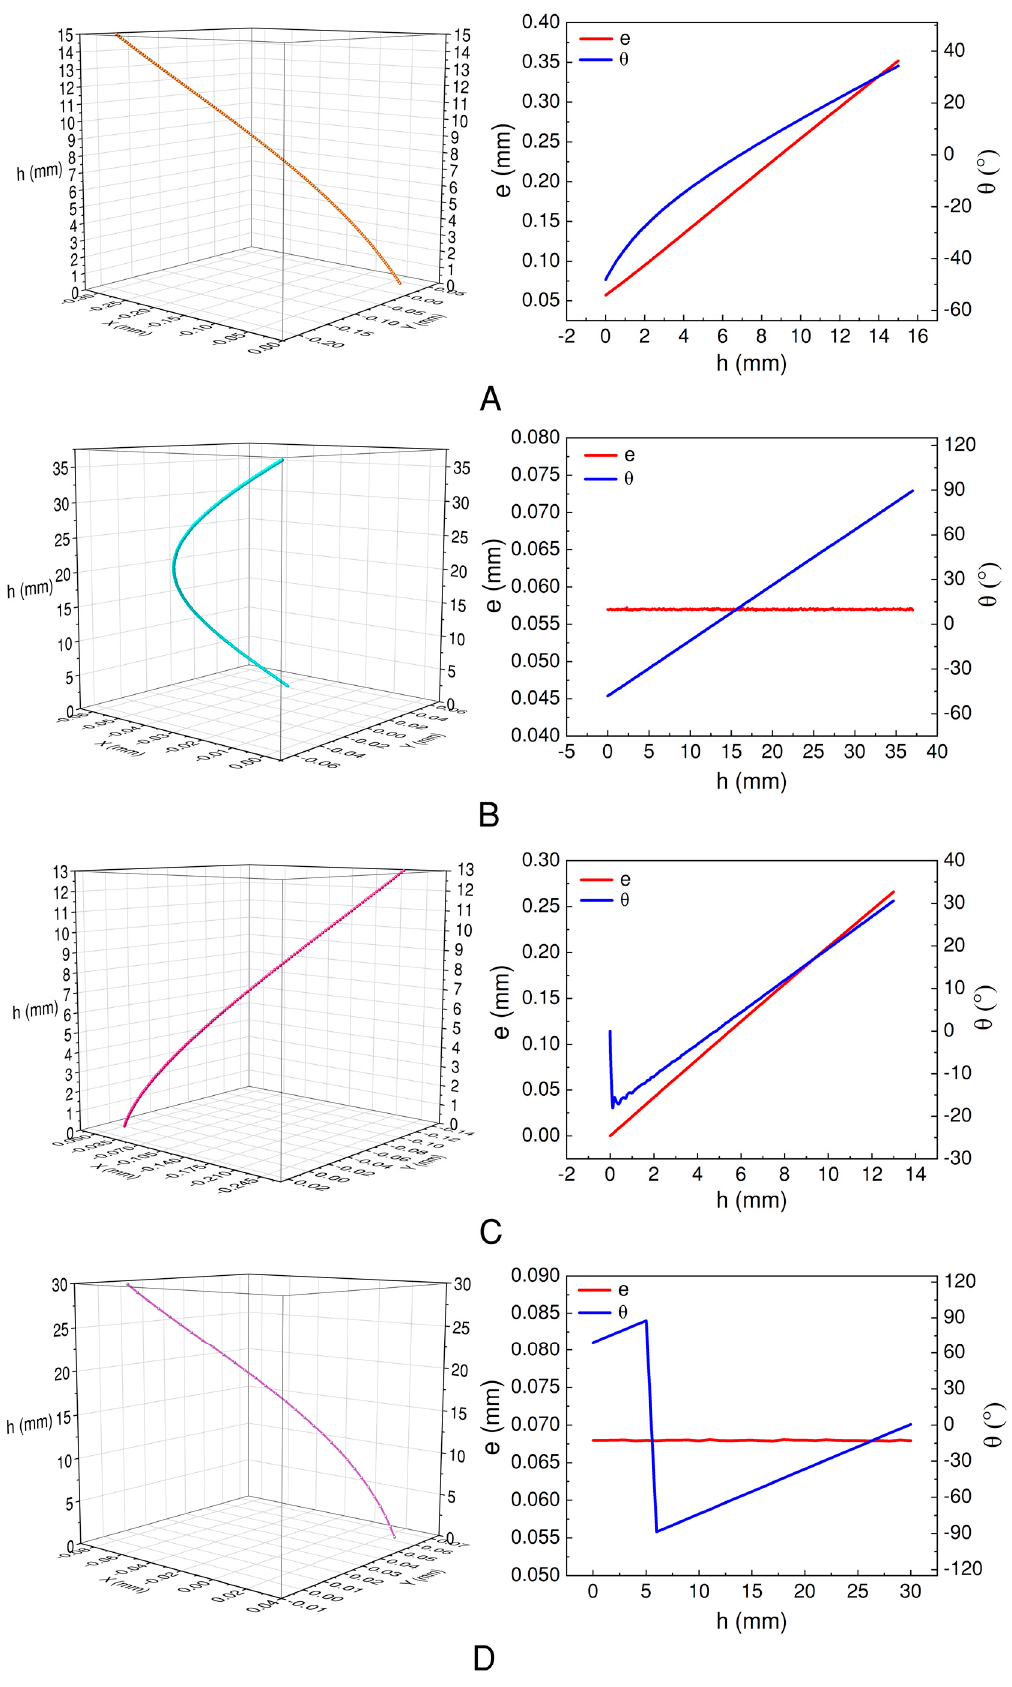
Figure 8. Centroid distribution of ( A – D )-type end milling cutter.